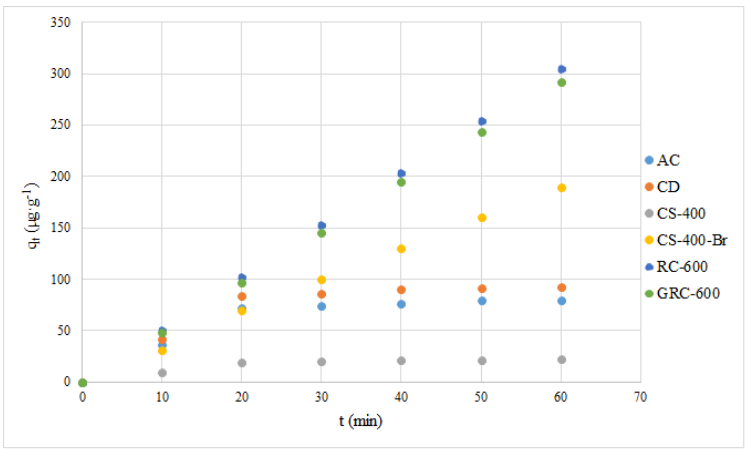
Figure 8. Accumulative Hg adsorption capacity for the tested sorbents.